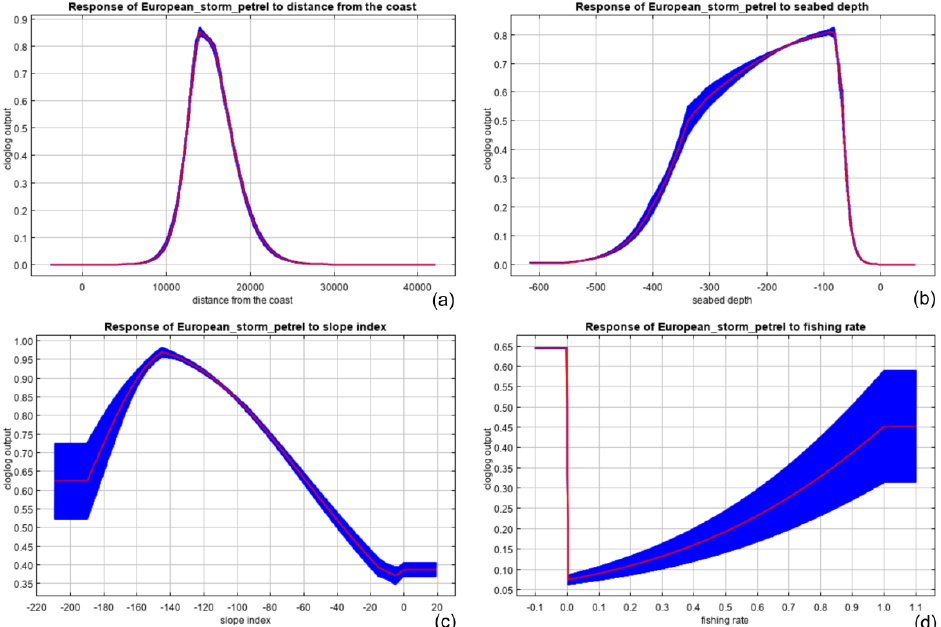
Figure 5. MaxEnt response curves for European storm petrels, showing the probability of presence against each variable: distance from the coast (m) ( a ), seabed depth (m) ( b ), slope index (m) ( c ), and fishing rate ( d ).